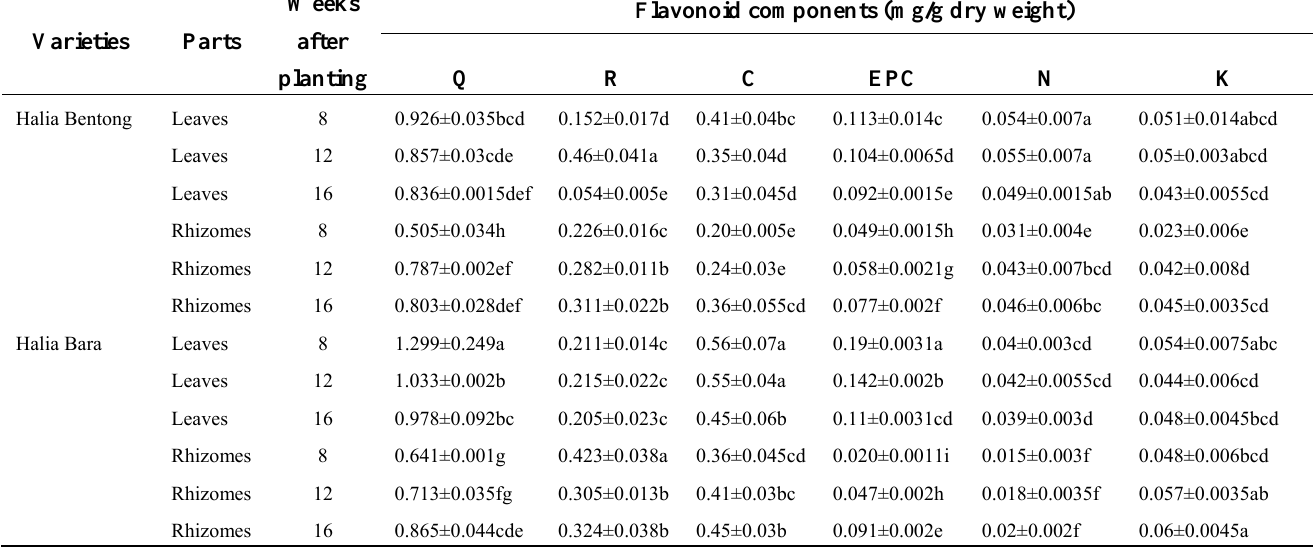
Table 2. Concentration of flavonoids components in the leaves and rhizomes harvested at 8, 12 and 16 weeks after planting in two varieties of Zingiber officinale . Weeks Flavonoid components (mg/g dry weight) Varieties Parts after planting